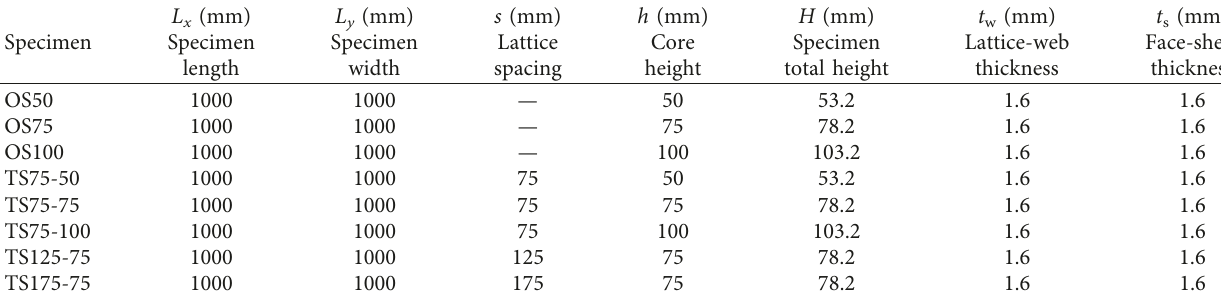
Figure 2: Foam core sandwich panels with lattice-web reinforcements. Table 1: Description of the specimens.